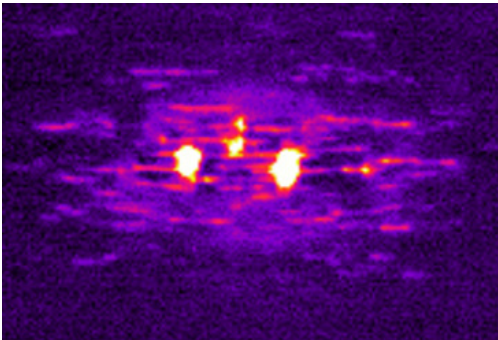
Figure 3. A higher spatial resolution ∆ T image taken at t = 0.036 s with the SC6000 camera of a specimen impacted at E = 8.3 J.